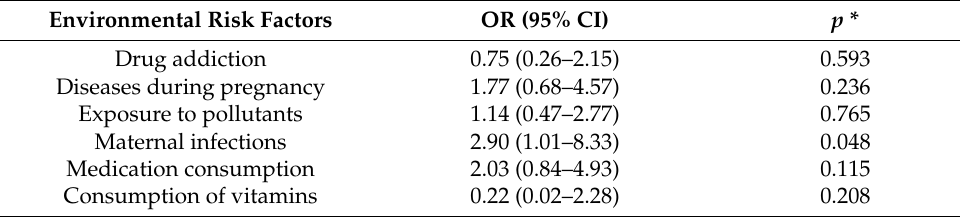
Table 3. Environmental factors analysed to determine the risk in the study